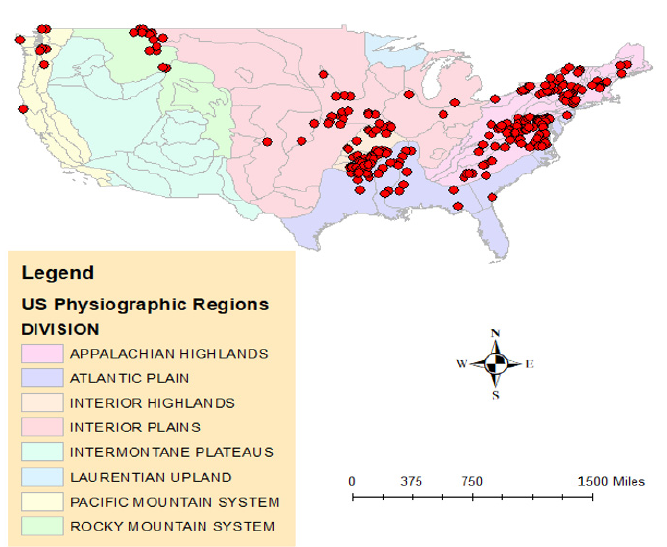
Figure 1. A total of 297 bridge collapse sites across different physiographic regions in the